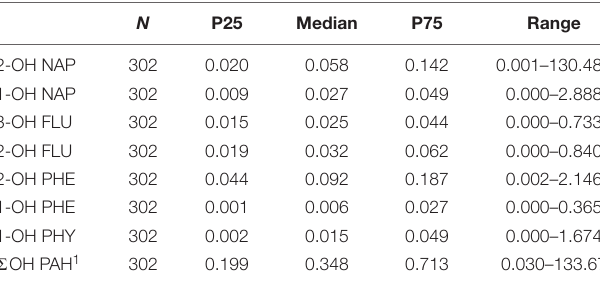
TABLE 3 | The concentrations of seven OH-PAHs in the urine sample ( µ